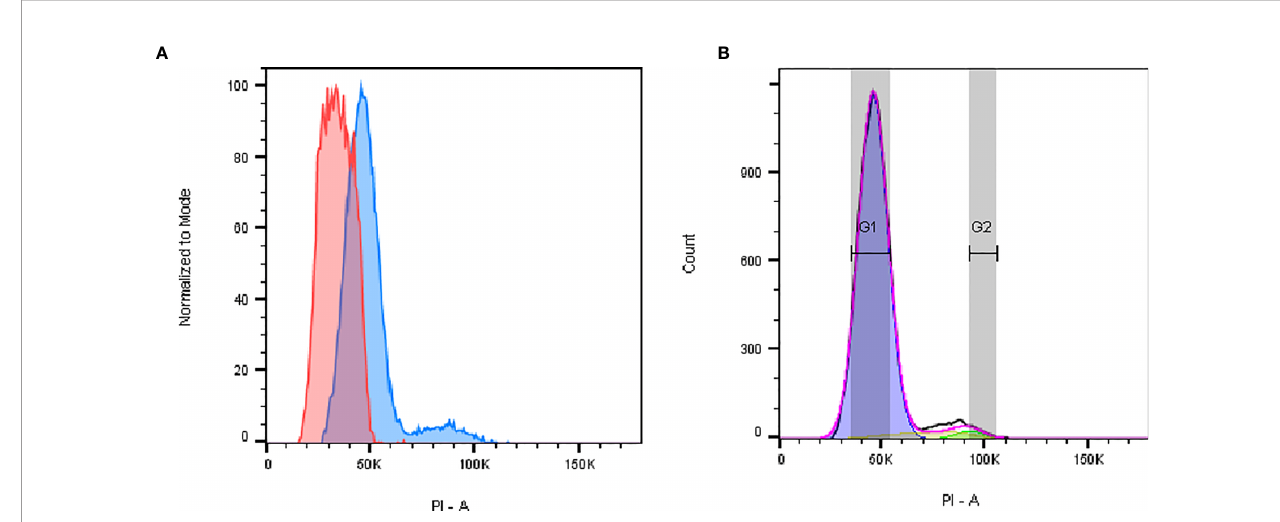
FIGURE 3 | Flow cytometric cell cycle histograms. Cells were fi xed with 70% ethanol and stained with PI. (A) Representative histogram of P1 (red) and P2 (blue) singlets in the cell cycle, showing that for P1 most of the cells are in G0/G1 phase. (B) P2 cell distribution in G0/G1 (blue, 92%), S (yellow, 5%), or G2/M (green, 2%) phases was determined using the Dean Jett Fox fi tting algorithm of FlowJo software (version 10.7), after excluding cell debris and aggregates. PI fl uorescence is proportional to DNA